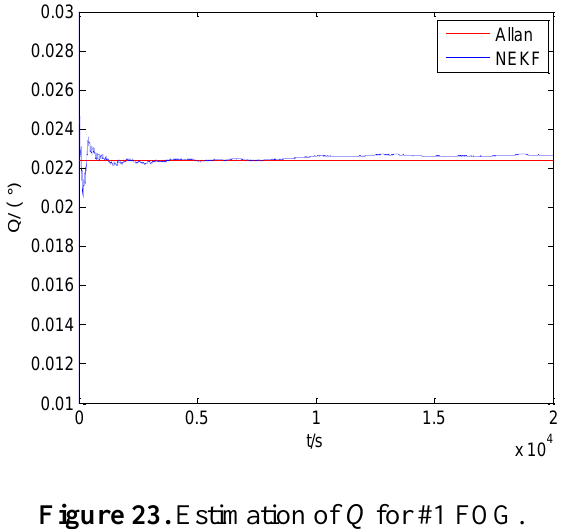
Figure 23. Estimation of Q for #1 FOG.